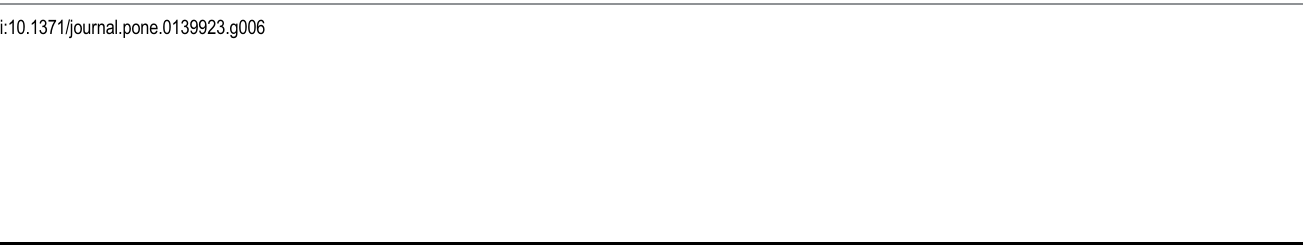
Fig 6. Frontal and sagittal kinematic waveforms for the hip, knee, and ankle of High-Responders (green), Low-Responders (blue), Non- Responders (red), and controls (grey) both pre (solid) and post-intervention (dashed), with peak loadings of predictor principal components illustrated with